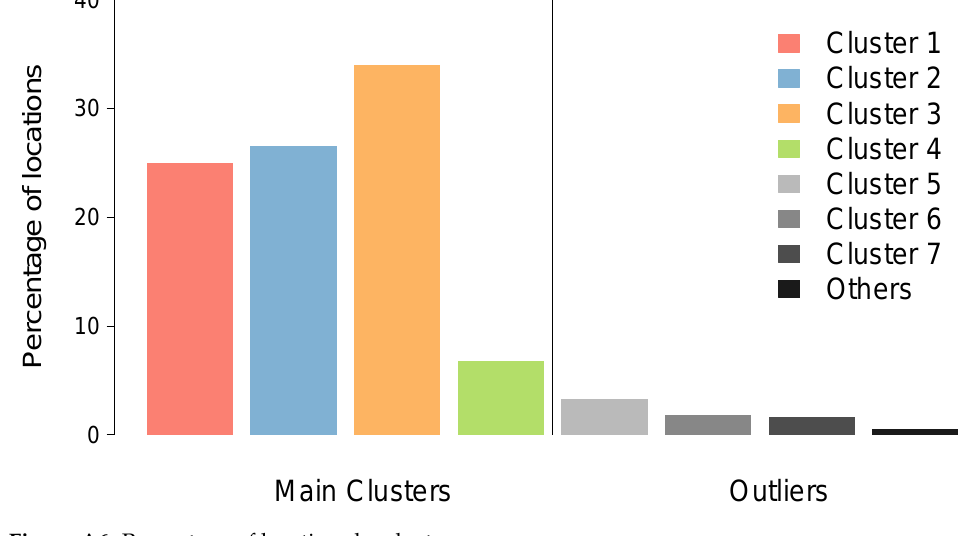
Figure A6. Percentage of locations by